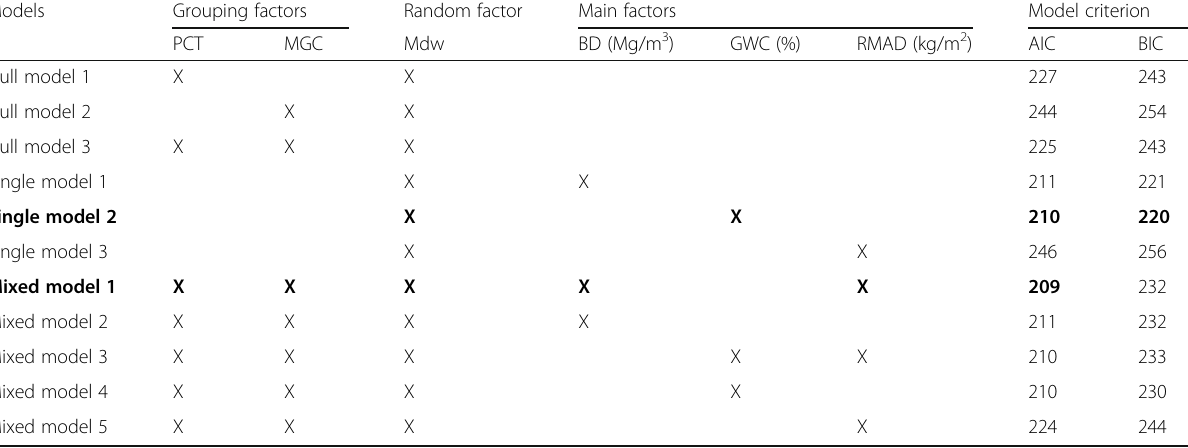
Table 2 Linear mixed-effects regression (LMER) results showing best explanatory models of soil resistance (SR) in comparison with null models. Best models are shown in bold font, based on lowest Akaike (AIC) and/or Bayesian (BIC) Information Criterions. Null models include one or more grouping factors and a random factor only, single models include one main factor (explanatory variable) and random factor only, and best models include one or more grouping factor, the random factor, and one or more main factors for dataset group A ( n = 252) derived from soils sampled over 3-week period in in subalpine meadows ( n = 5) at Yosemite National Park, USA. An “ X ” denotes model factors included within a given model. Grouping factors included plant community type (PCT) and meadow gradient class (MGC), and the random factor is each of the five subalpine meadows (Mdw). Main factors included the following explanatory variables: bulk density (BD), gravimetric water content (GWC), and root mass areal